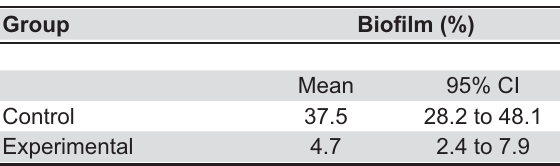
Table 1- (cid:2)(cid:3)(cid:4)(cid:5)(cid:6)(cid:7)(cid:2)(cid:6)(cid:8)(cid:4)(cid:9)(cid:10)(cid:5)(cid:2)(cid:4)(cid:11)(cid:2)(cid:12)(cid:13)(cid:10)(cid:5)(cid:9)(cid:14)(cid:13)(cid:2)(cid:15)(cid:16)(cid:4)(cid:17)(cid:7)(cid:8)(cid:2)(cid:18)(cid:14)(cid:13)(cid:19)(cid:13)(cid:10)(cid:20)(cid:13)(cid:2)(cid:21)(cid:6)(cid:19)(cid:2) percentage of total denture surface area) in the control group (Control) and after treatment (Experimental) with